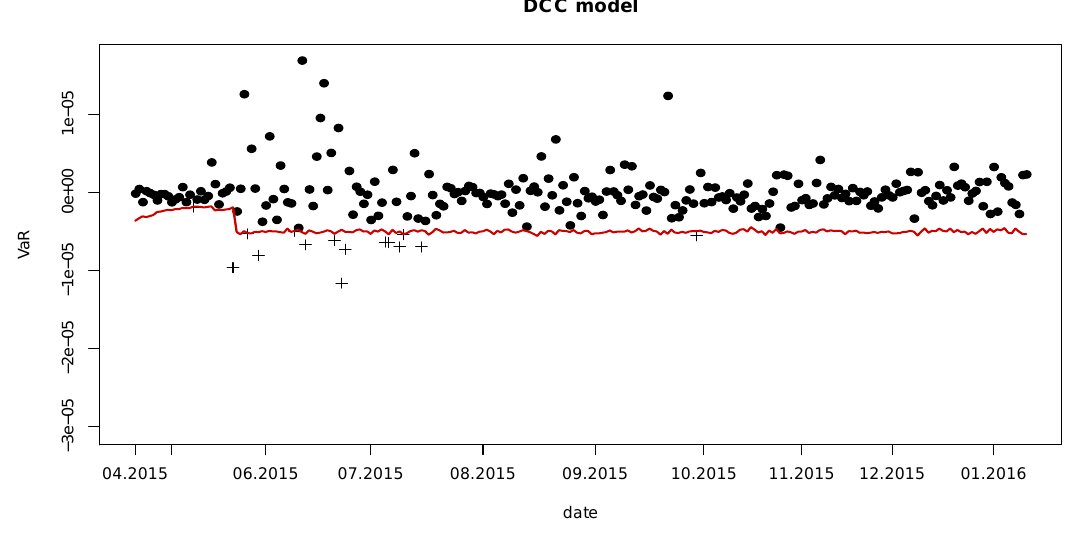
Figure 6: Exceedances plot for VaR ( α ) with α = 0.05 on the ExeCoin-SocialXBot portfolio for the DCC model. The dots represent the empirical portfolio value stated by the data, the “+” signs correspond to the exceedances.